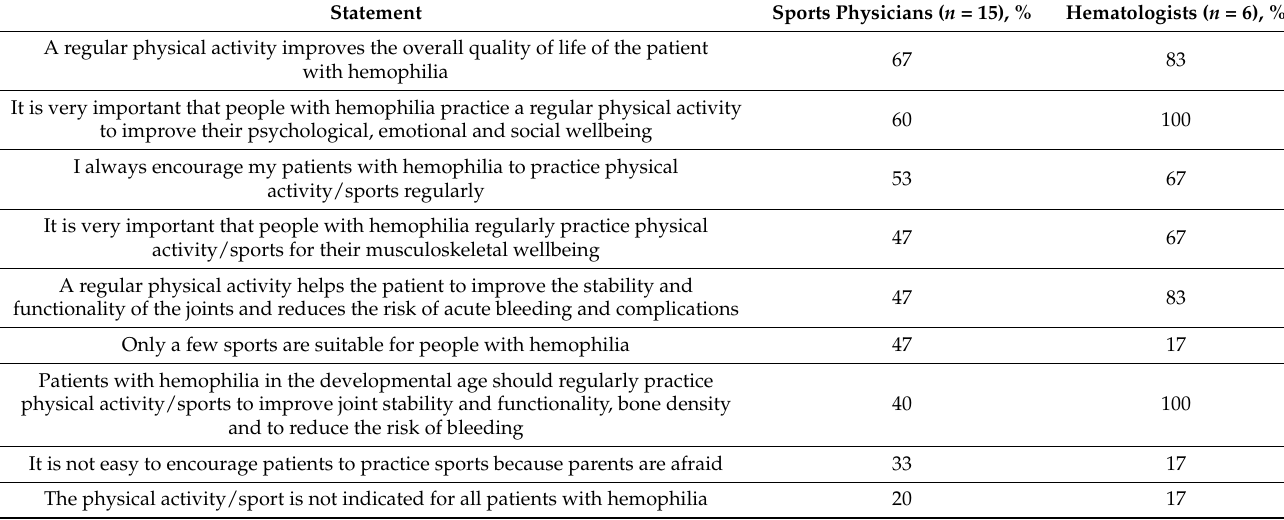
Table 1. The opinion of sports physicians and hematologists on the relevance of regular physical activity (exercise) in people with hemophilia; percentage of participants expressing a high level of agreement with the statement. Statement Sports Physicians ( n = 15), % Hematologists ( n = 6), %